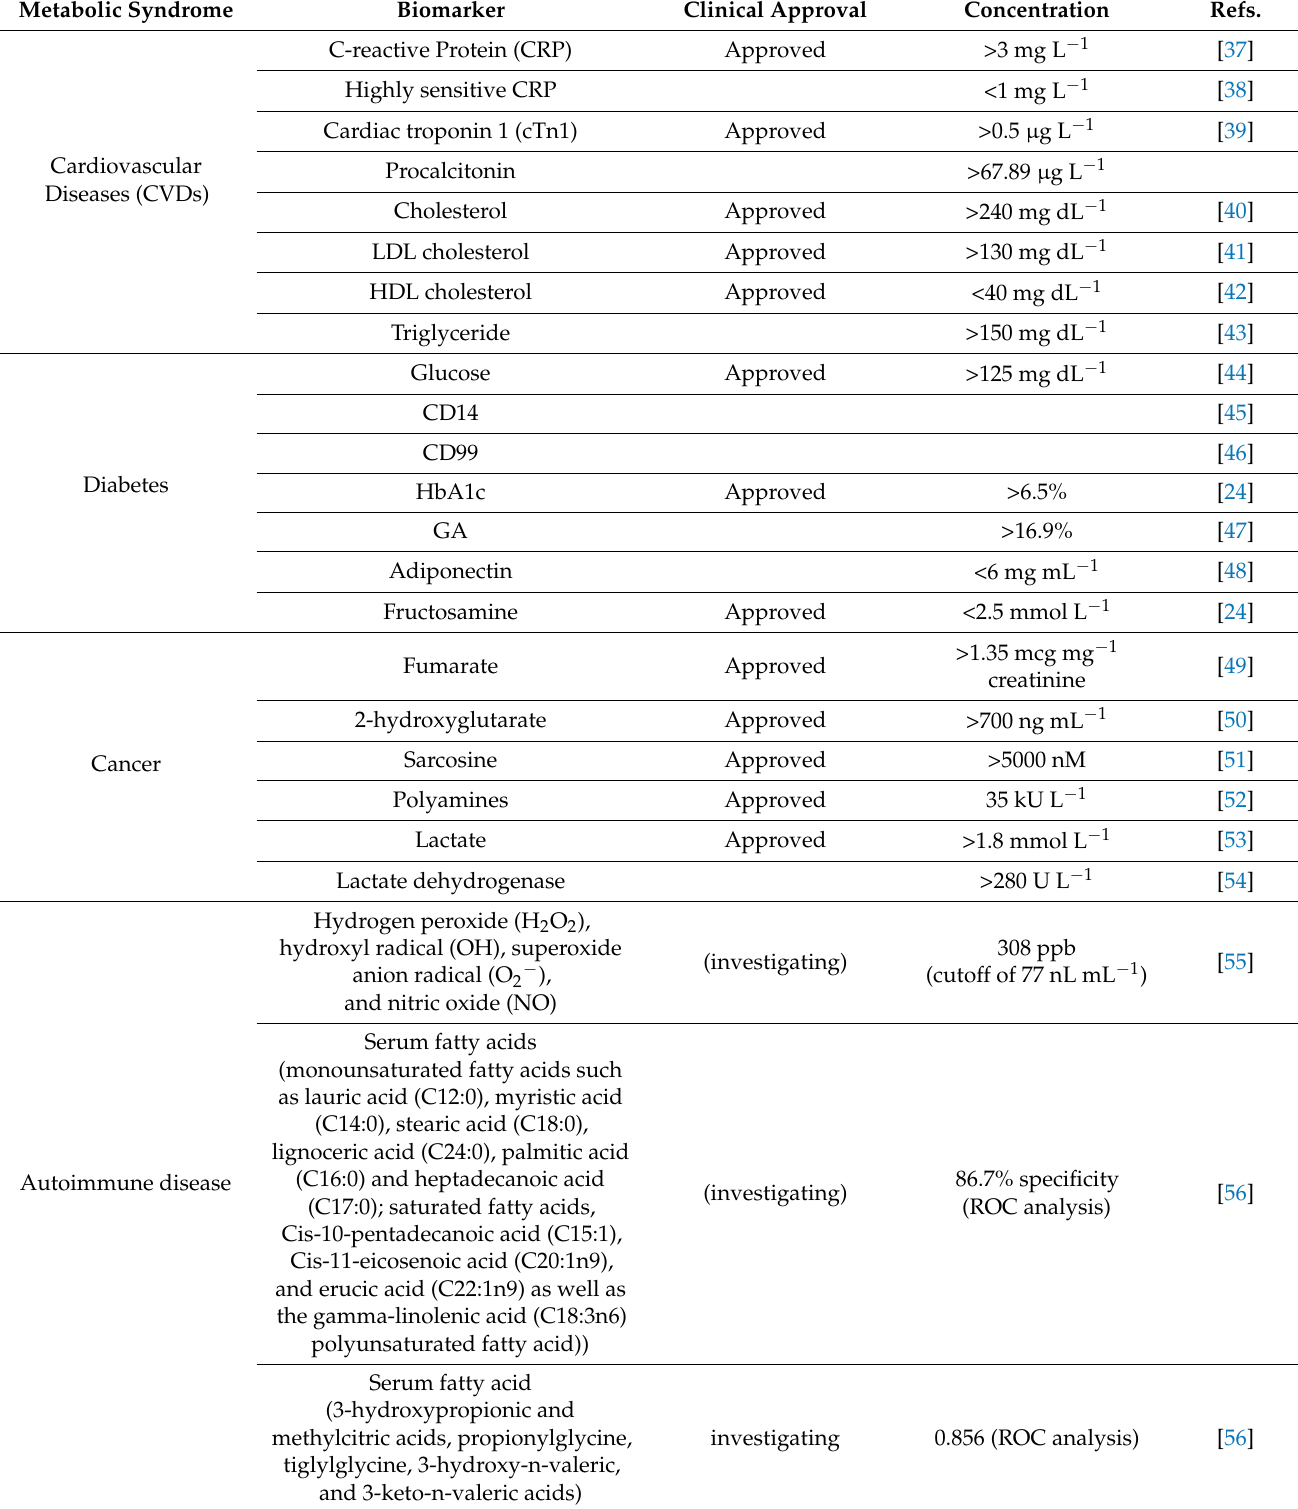
Table 1. Metabolic syndrome biomarkers and its relevant